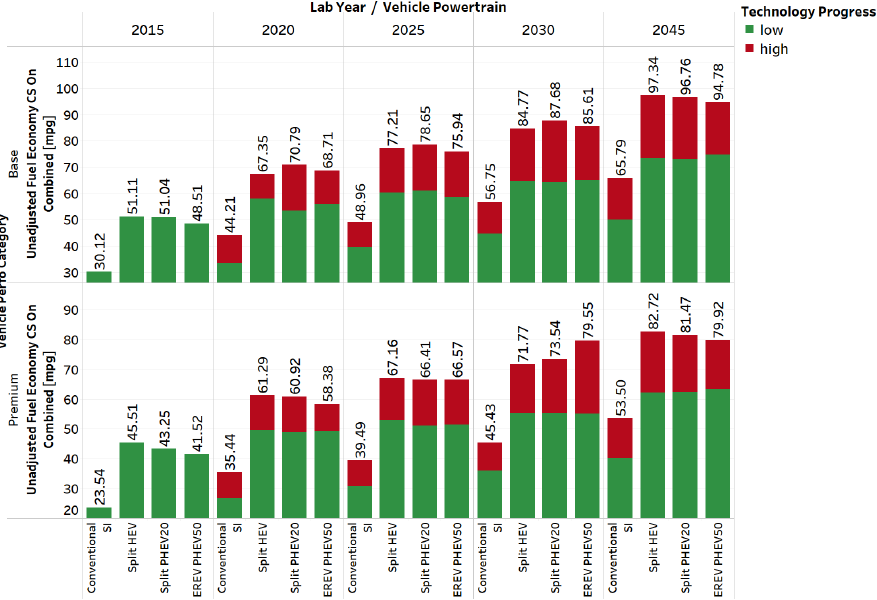
Figure 10. Unadjusted fuel economy on combined driving cycle for midsize vehicles.